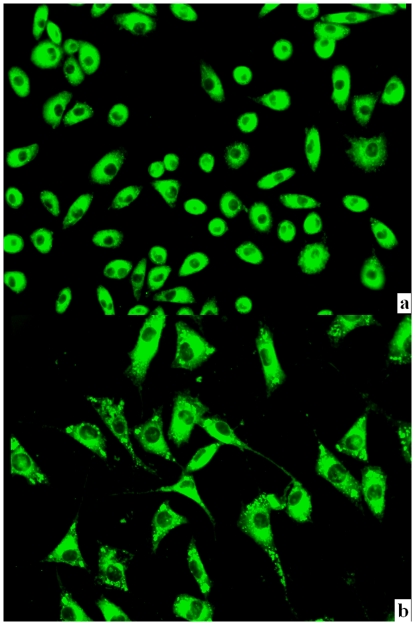
MKN-28 (
Fig. 9.a.
) and LoVo (
Fig. 9.b.
) cells incubated with coumarin-6-loaded NPs.It was obvious that the fluorescent signal deposited mostly in the peripheral region of cells, with little fluorescent signal observed inside the nuclei.